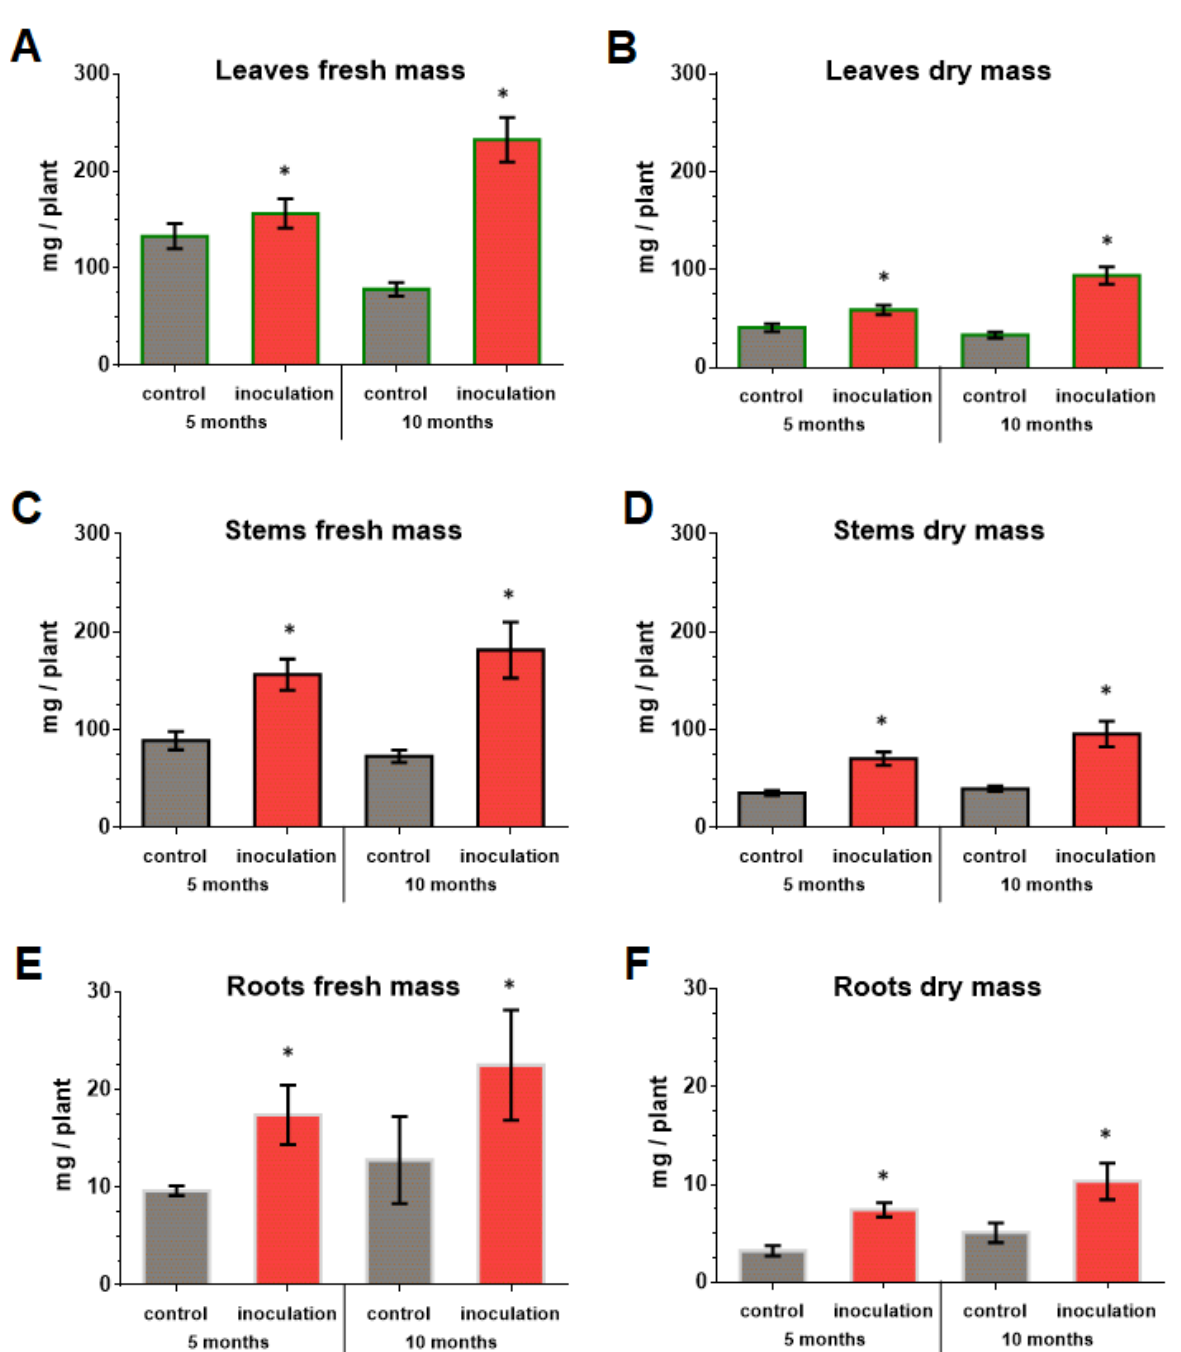
Figure 8. Response of V. macrocarpon leaves ’ wet ( A ) and dry ( B ) mass, stems ’ wet ( C ) and dry ( D ) mass, roots ’ wet ( E ) and dry ( F ) mass after 5 and 10 months co-cultivation with P. fortinii DSE2 isolate. * indicates statistically significant differences after Mann – Whitney correction was applied, р < 0.05.